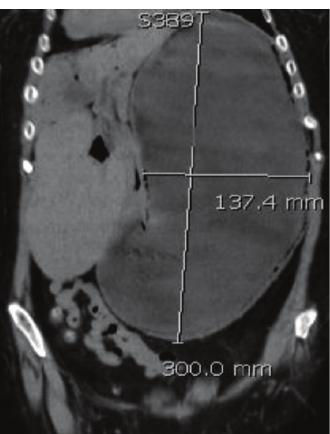
Figure 1: Gastric dilatation on CT scan, coronal reformat.